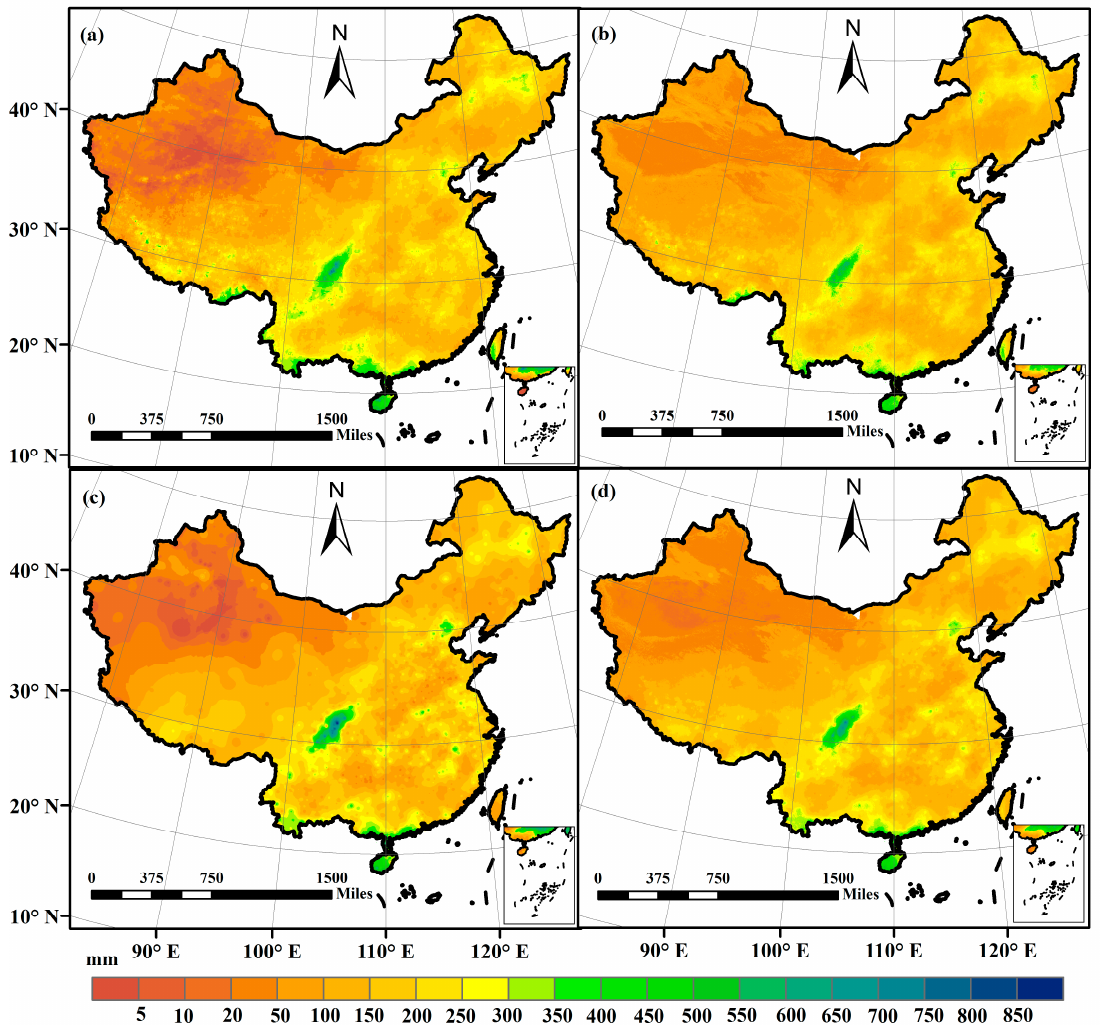
Figure 6. Precipitation estimates in July, 2018. ( a ) IMERG; ( b ) RF; ( c ) IDW; ( d ) The merging method.